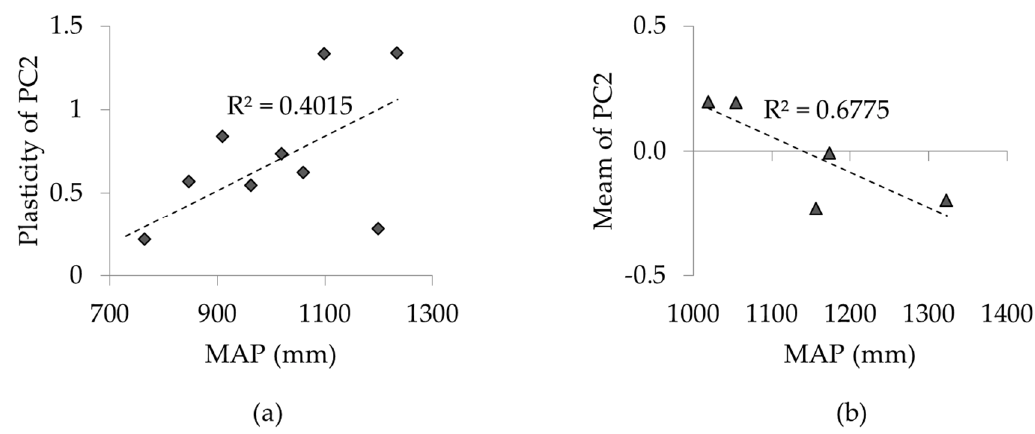
Figure 4. Relationships among rainfall (MAP, data from Table 1) with ( a ) plasticity of Principal Component 2 for P. patula ( ); and ( b ) mean of Principal Component 2 for P. pseudostrobus ( ).